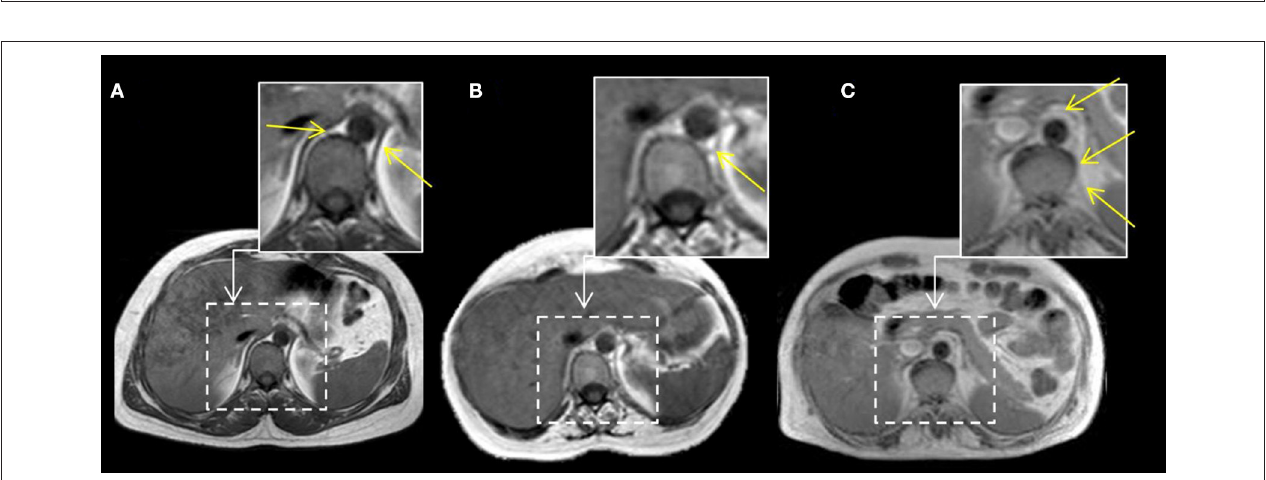
FIGURE 2 | MRI T1w abdominal sections of three LOPD patients. Yellow arrows point to both diaphragm pillars. In case (A) , right and left diaphragm pillars are visible and do not show fatty replacement (Mercuri score 0). In case (B) , left diaphragm pillar is visible and partially infiltrated, whereas right diaphragm pillar is absent (left pillar Mercuri score 3 points). In case (C) , we can observe fully replaced diaphragm pillars at both sides (Mercuri score 4 points).